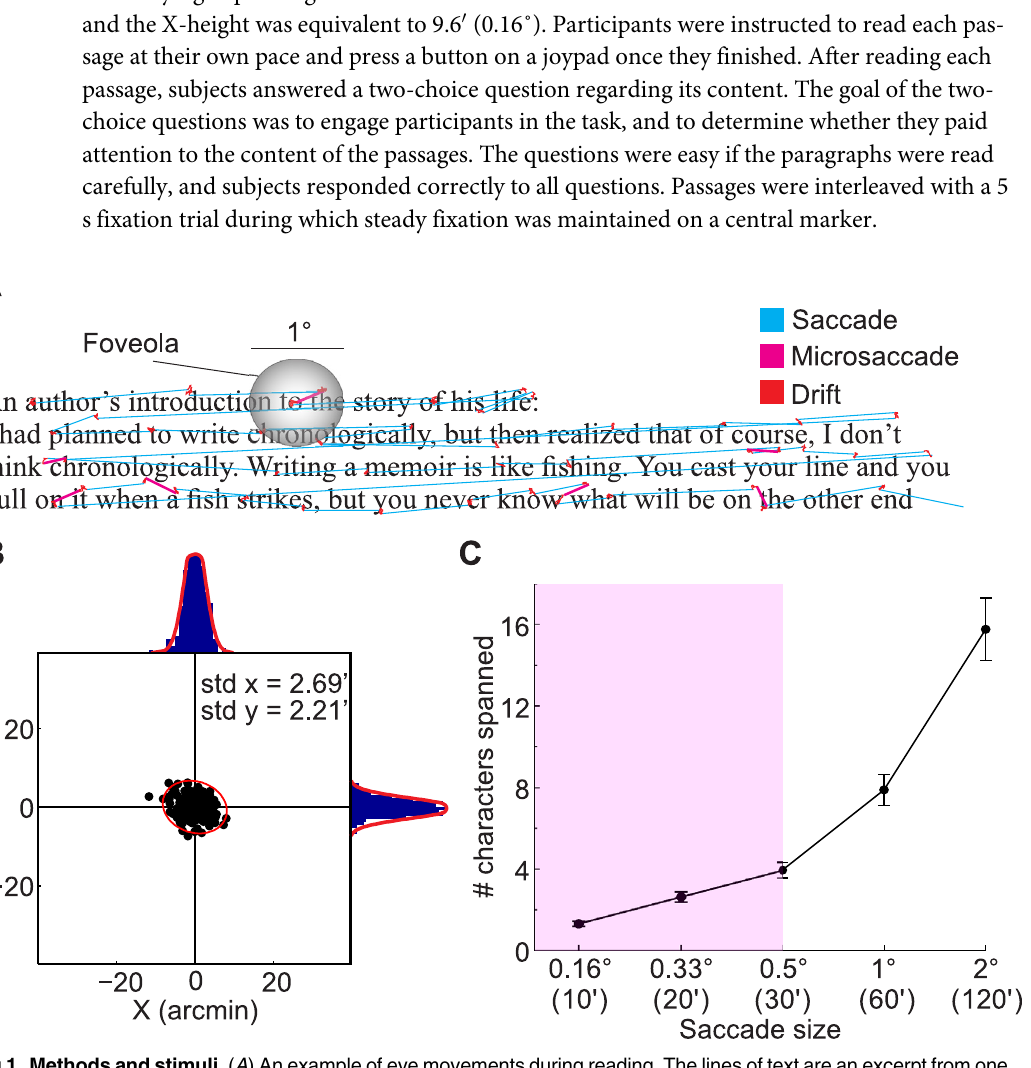
Fig 1. Methods and stimuli. ( A ) An exampleof eye movementsduringreading.The lines of text are an excerpt from one of the paragraphs used in the study. The size of the foveola(the high-acuityregionof the retina) is also shown for comparison. Different types of eye movements are color-coded.( B ) Accuracy in gaze localization. Error in gaze localization for one subject, each dot representsthe offset betweenthe gaze positionand the fixated marker in an individual repetitionof the calibrationprocedure (see Methods for details). The 99% confidenceellipseand the marginal distributions with their Gaussian fits are also shown. The numberson the graph indicate horizontal and vertical standard deviations of the distribution.( C ) Number of characters spannedas a function of saccade size. The shaded area in the graph represents the microsaccade range. Data points are averages across observers, and error bars represent s.e.m.